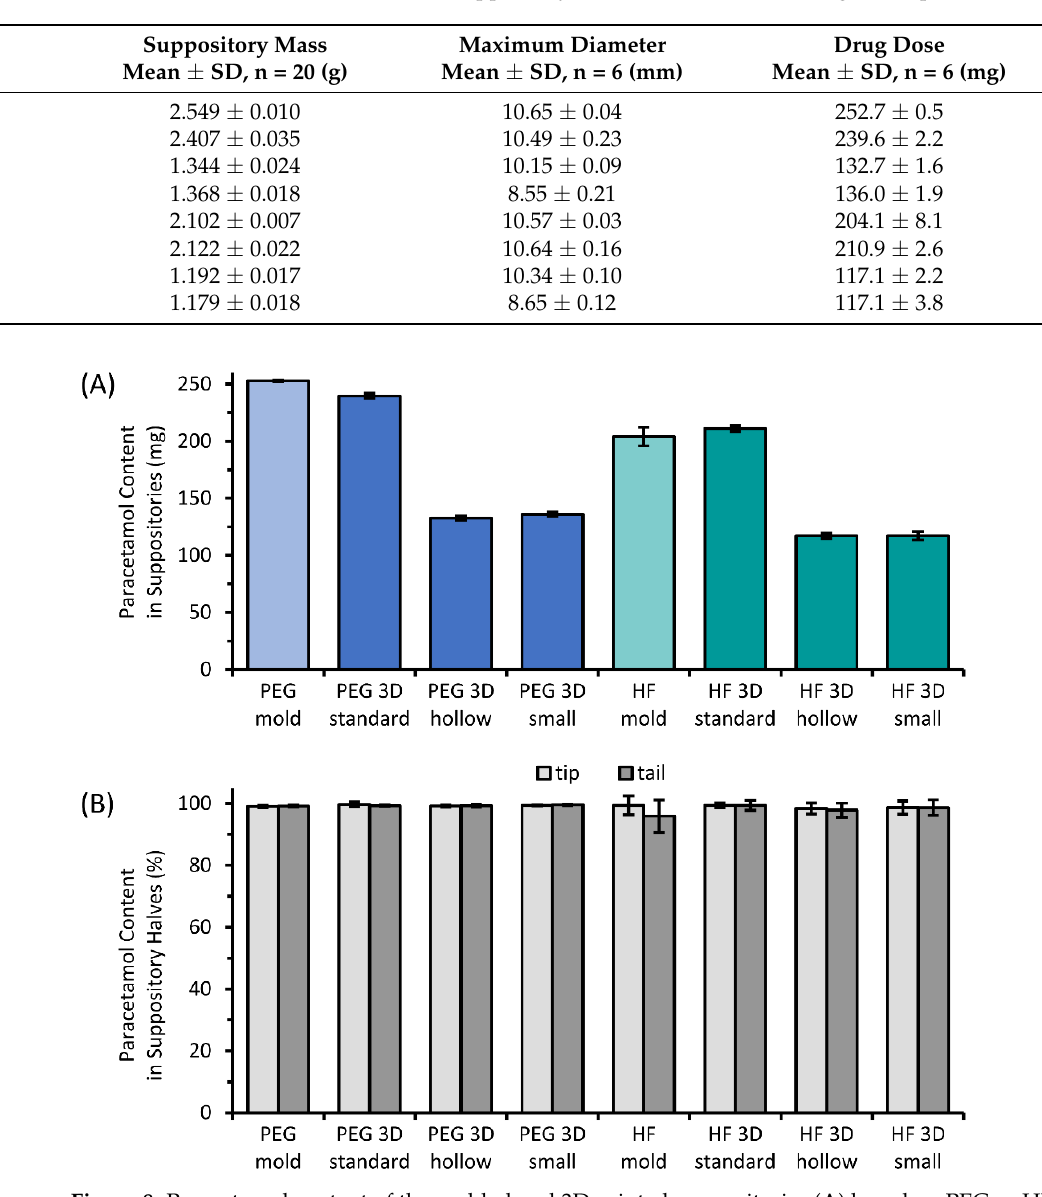
Figure 8. Paracetamol content of the molded and 3D printed suppositories ( A ) based on PEG or HF and the percent drug content in the tip and tail part of those suppositories ( B ); mean ± SD, n = 6.